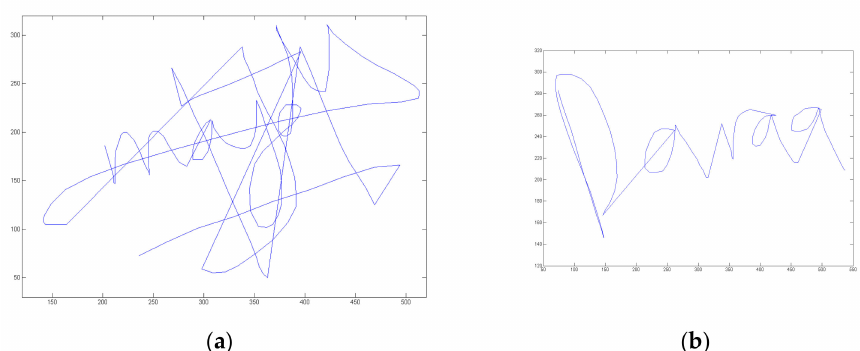
Figure 3. Examples of skilled forgeries of ( a ) the usual signature and ( b ) the associated place information displayed in Figure 1.